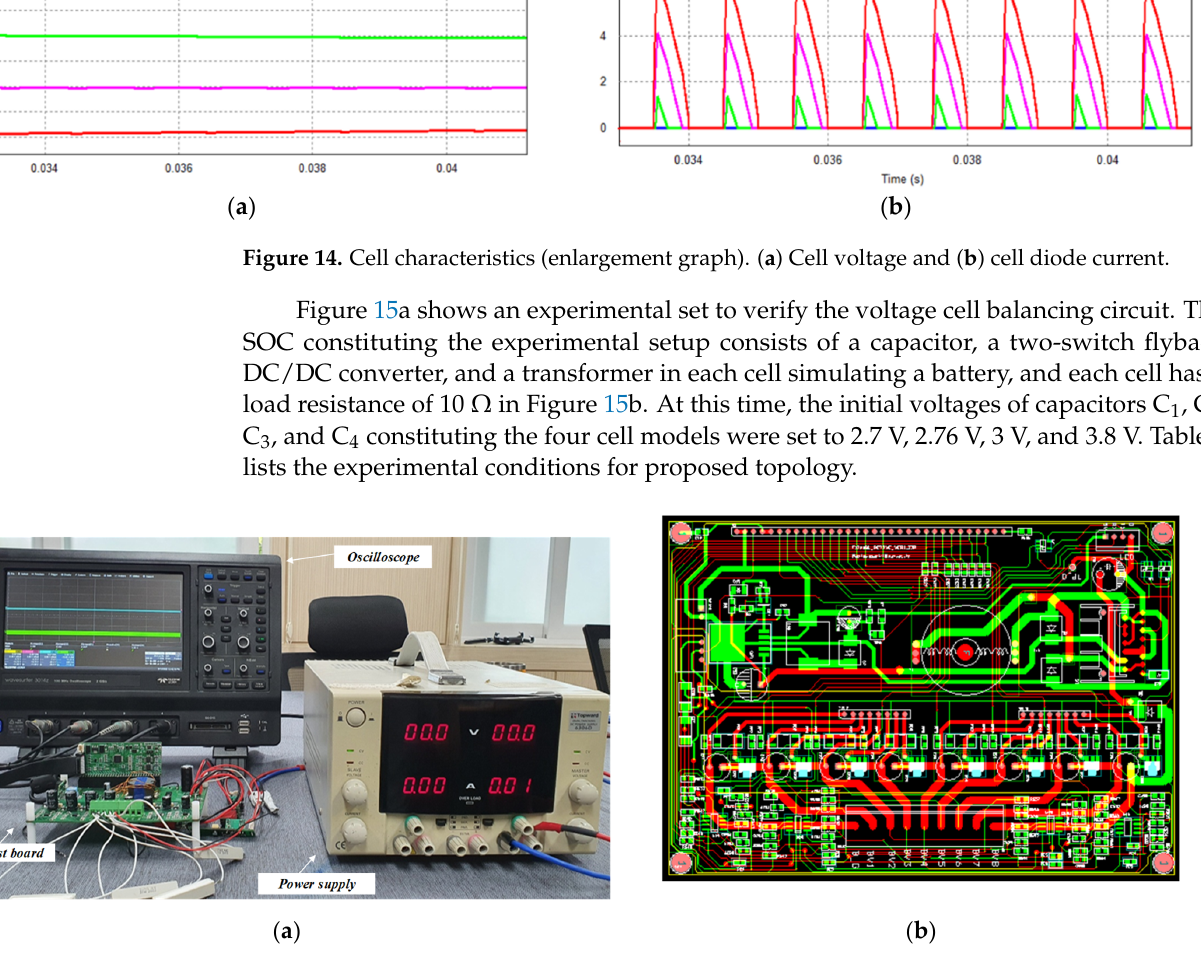
Figure 14. Cell characteristics (enlargement graph). ( a ) Cell voltage and ( b ) cell diode current.